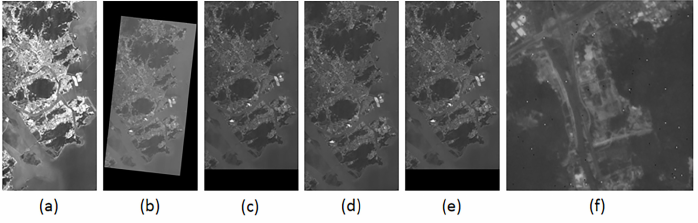
Figure 11. Rotation, scaling, and noise experiment of OHS data. ( a ) is the target image; ( b ) is the original image with artificial rotation and scaling transformation, ( c ) is the registration result of ( b ); ( d ) is the target image with artificial noise; ( e ) is the registration result of ( d ); ( f ) is the detail display of ( d ) adding